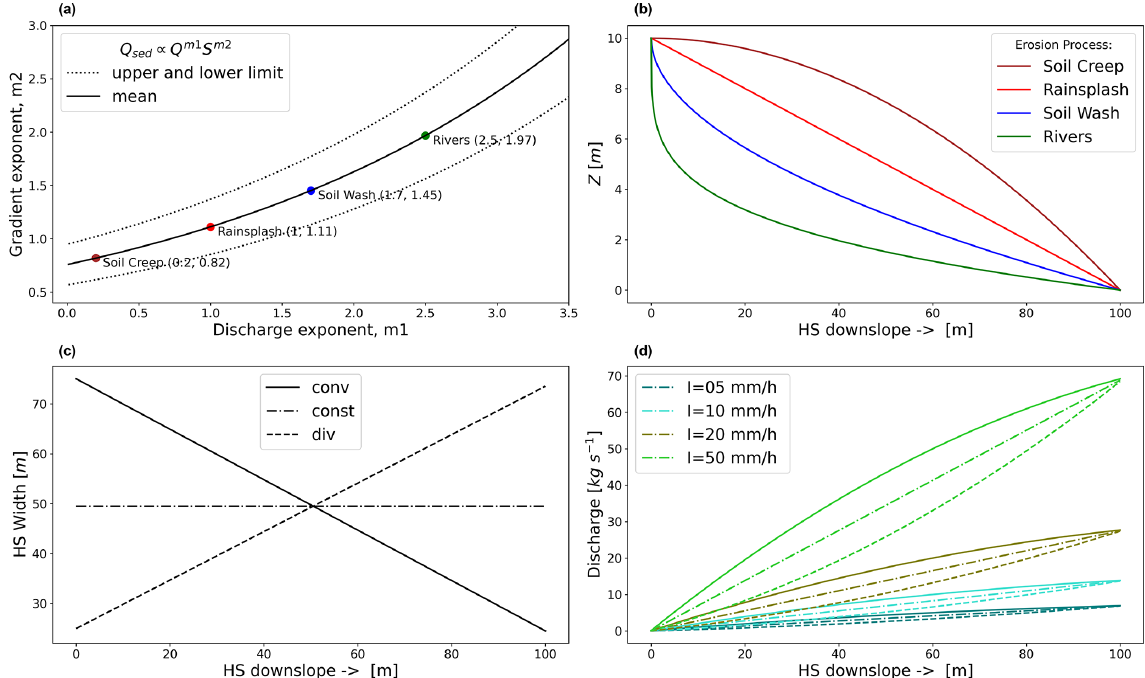
Figure 3. (a) Discharge ( m 1 ) and gradient ( m 2 ) exponent (after Kirkby, 1990, cited in Beven, 1996) for characterizing sediment transport capacity, (b) typical hillslope (and river) profiles as a result of a dominant erosion process (Kirkby, 1971), (c) assumed width distributions along the flow path and (d) resulting steady-state discharge along the hillslope for different rainfall infiltration excess intensities. The line types in panel (d) correspond to the width functions in panel (c)